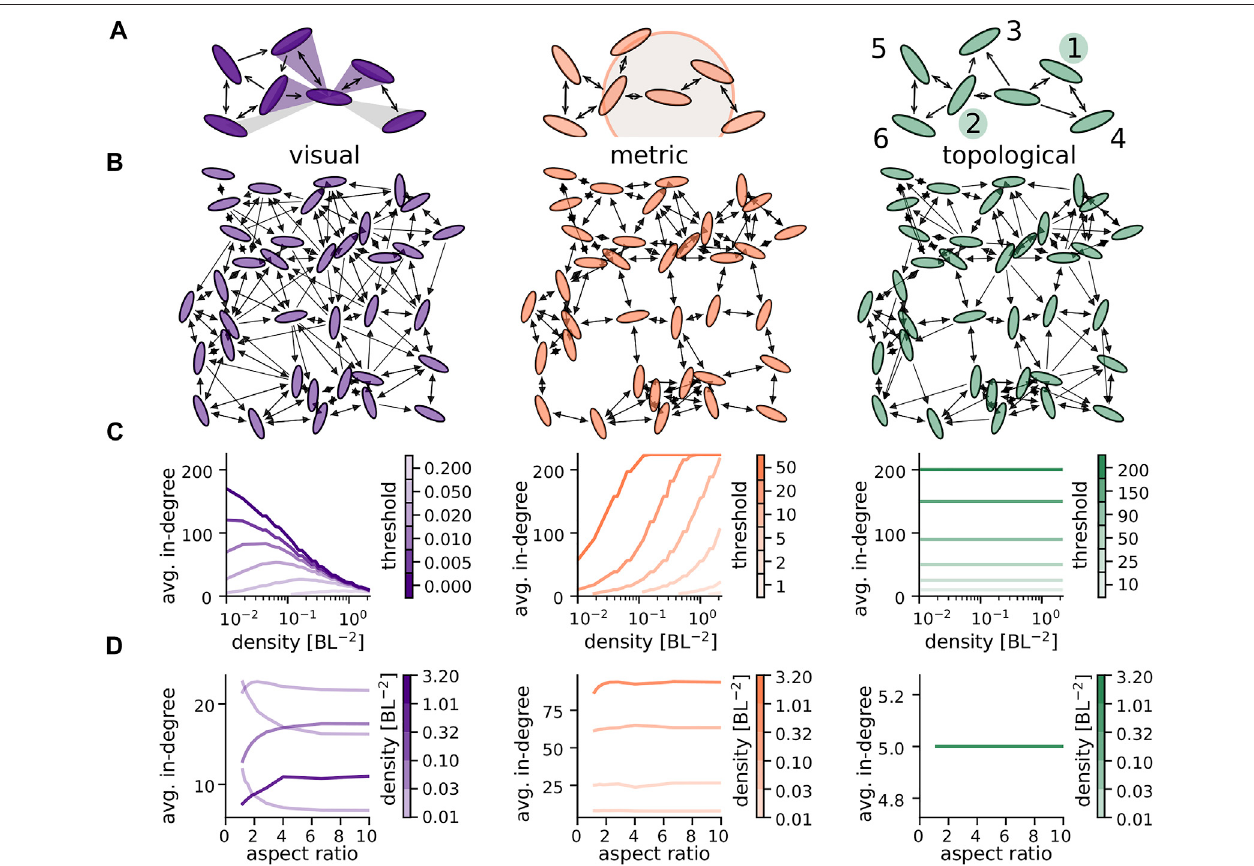
FIGURE1| The differentnetwork types: (A) illustration of rules determining incoming network links ofthecentralindividual (white). Left: visual angles needs to be larger than a threshold value, θ visual (cid:1) 0.43, (purple shaded areas indicate visual angles that ful fi ll this requirement, light grey ones do not, threshold chosen very high for the purpose of illustration). Center: metric distance between individuals needs to be below a certain threshold (indicated by a circle). Right: incoming links are coming from fi xed number of nearest neighbors (here 2) for the topological model. Numbers indicate closeness rank. (B) Examples of the different networks for g (cid:1) 1.4, η pos (cid:1) 0.5, N (cid:1) 36, κ (cid:1) 0.5, w (cid:1) 0.3 using the same positions, orientations and total number of links (thresholds: θ visual (cid:1) 0.254, (cid:1) 2.1035, θ (cid:1) 5, yielding 180 directed links). (C) Average in-degree as a function of density for different threshold values indicated by line color. The θ metric topo average in-degree of the different network types show a very distinct dependence on density. (D) In fl uence of ellipses, aspect ratio on avg. in-degree for different density regimes indicated by line color for fi xed thresholds, θ visual (cid:1) 0.05, θ metric (cid:1) 8, θ topo (cid:1) 5. At low density circles (aspect 1) are visible over larger distancesleadingto an increasein averagein-degree.Athigh densities,elongated ellipses (high aspectratio)causefewer occlusionswhichinturnincreasesthe average in-degree. N (cid:1) 225 in (C) and